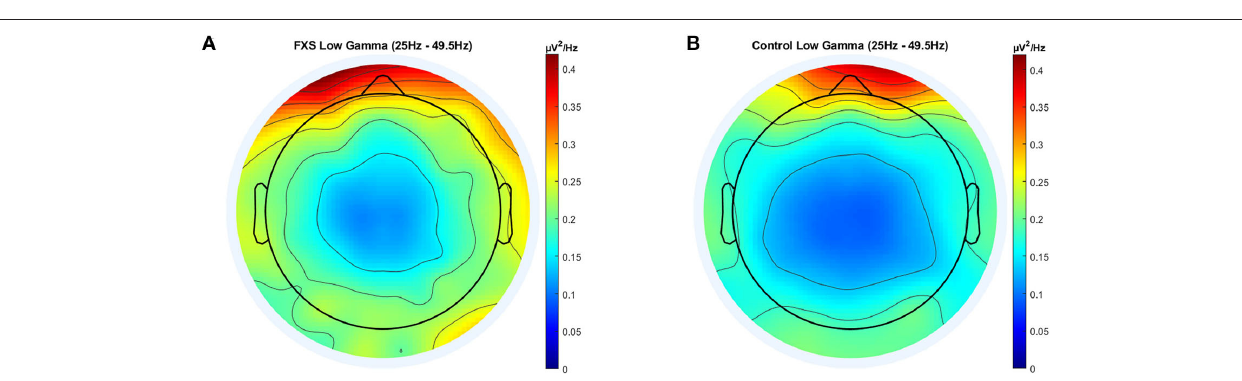
0.0001, η 2 = 0.32] and age [ F (1,89) = 53.65, p < 0.0001, η 2 = 0.38], and a significant interaction between age and ROI [ F (4.9,439.2) = 10.31, p < 0.0001, η 2 = 0.1] but no group effects or